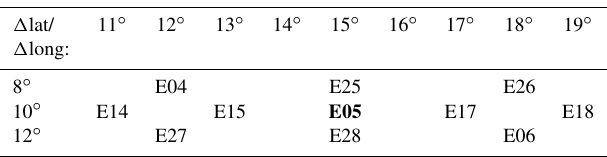
Table 1. Labeling of experiments with different distance criteria that are used to estimate the uncertainty in the blocking identifi- cation method. Differences in longitude (cid:49) long and latitude (cid:49) lat are given in degrees. Most of the results presented in Sects. 4.2, 4.4 and 5 are based on the E05 setup; hence the entry is highlighted in